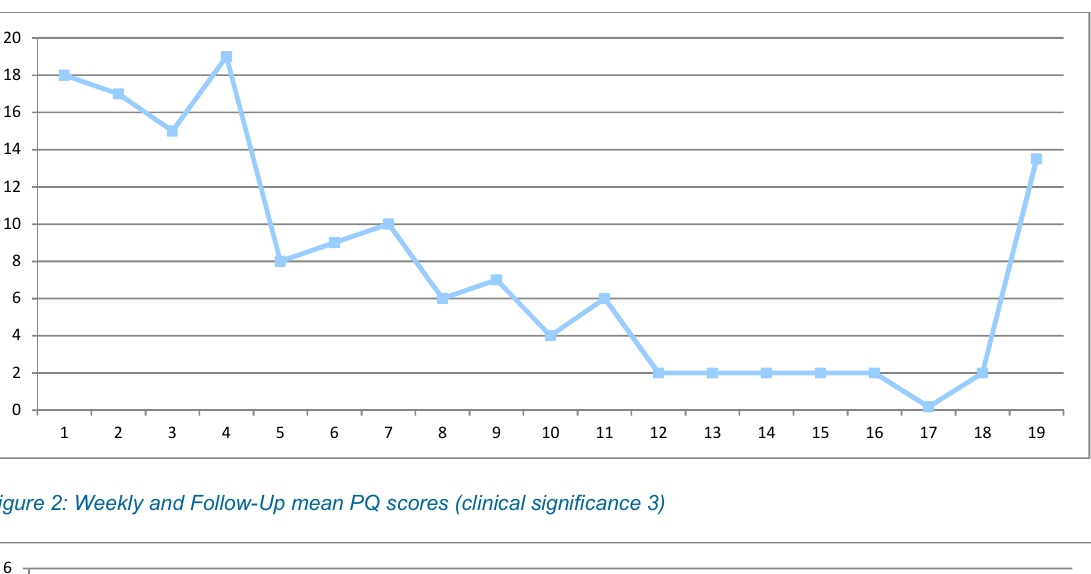
Figure 1: Weekly and Follow-Up CORE-10 scores (clinical significance 10)